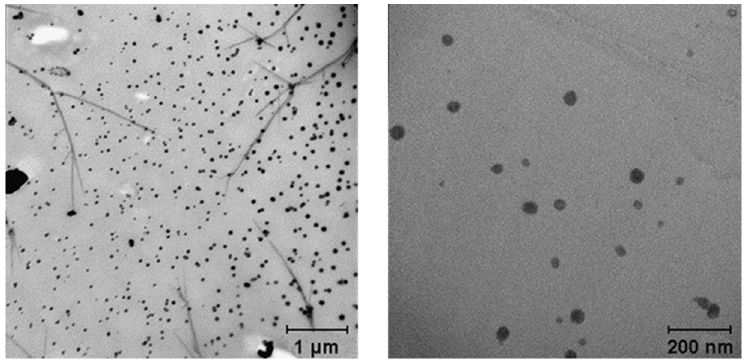
Figure 5. TEM images of suspensions of a CaNP 7 preparation obtained in 30 × reaction volume. This nanomaterial was also assayed for stability. During storage for three months, the hydrodynamic size did not change significantly (Figure 6).